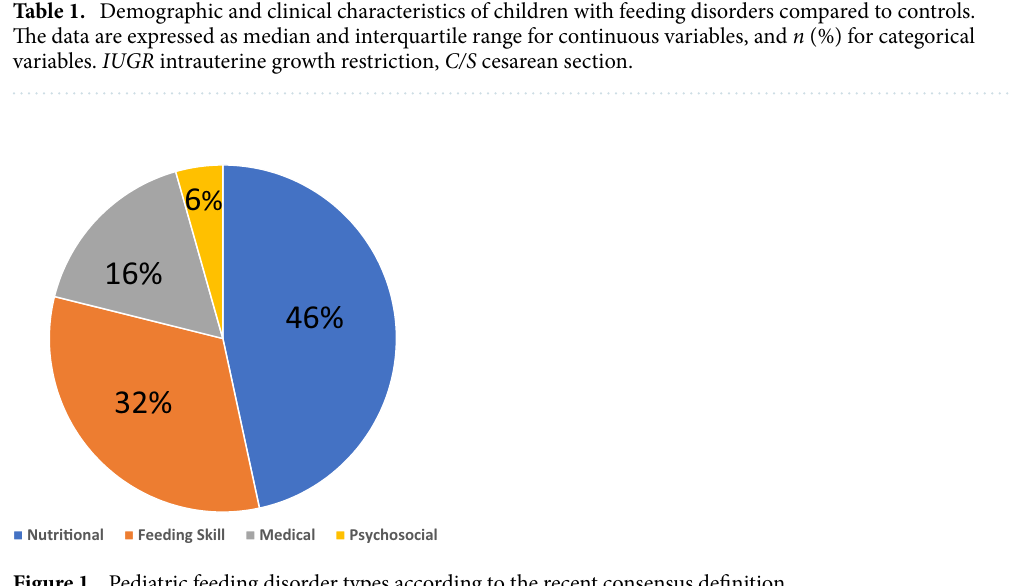
Figure 1. Pediatric feeding disorder types according to the recent consensus